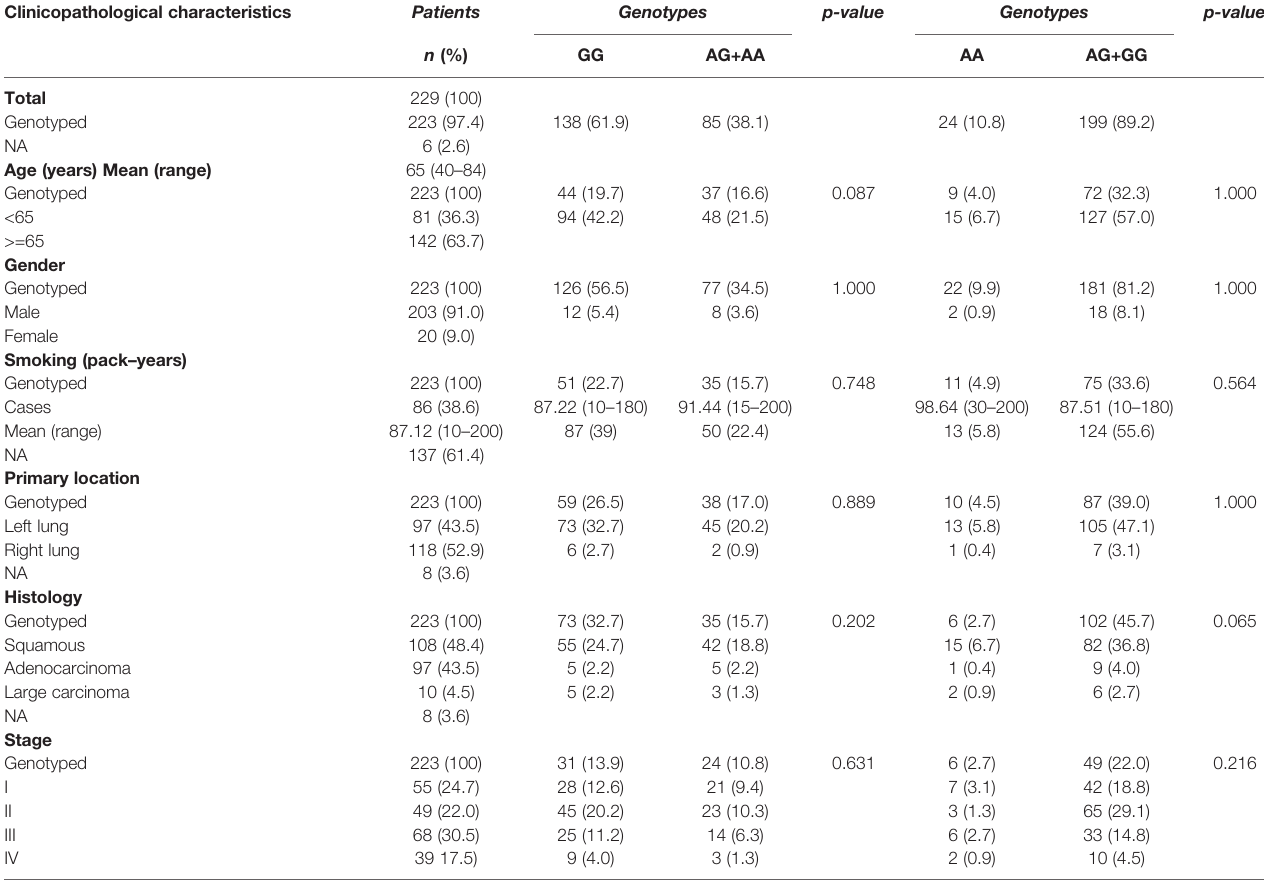
TABLE 8 | Relationships between clinicopathological variables of NSCLC patients and LtBR rs10849448 genotypes. Clinicopathological